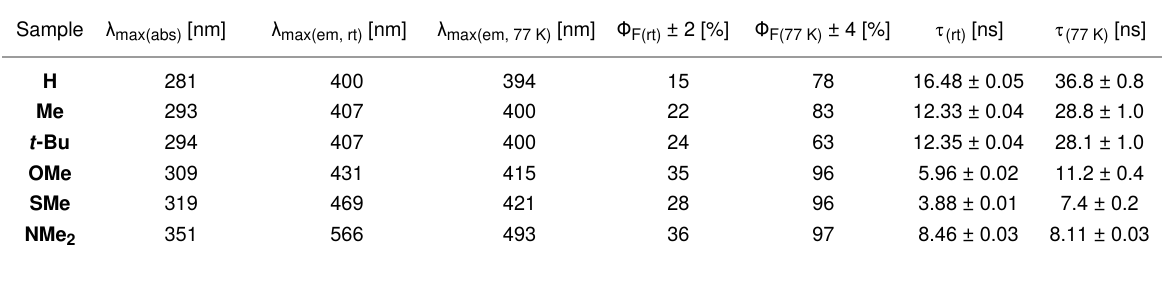
Table 1: Photophysical properties of the samples in fluid at rt and 77 K. In all cases, the lifetimes were fitted mono-exponentially. Both at rt and 77 K, lifetimes were measured at λ max .